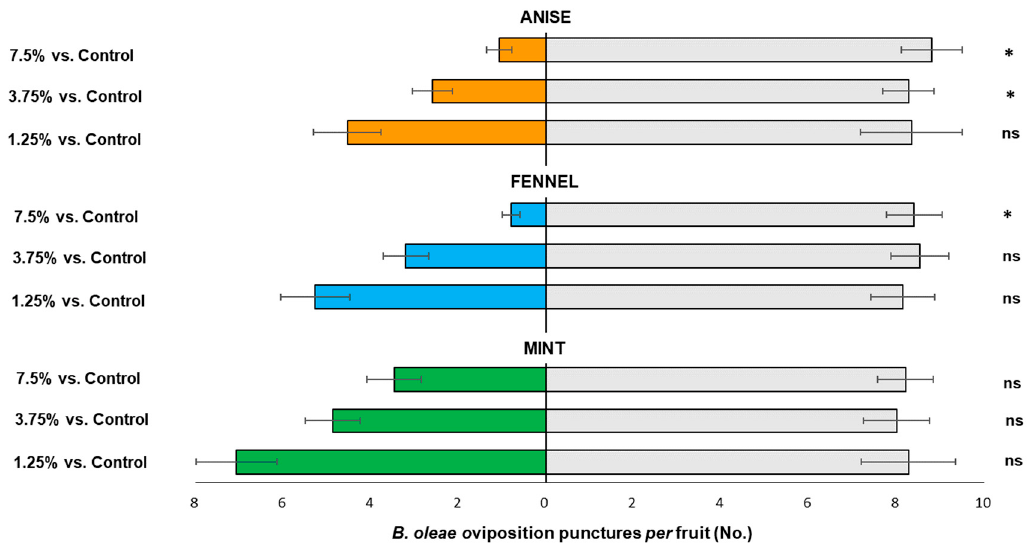
Figure 2. Oviposition behavior (mean oviposition puncture ± SE) of B. oleae females in choice trials with essential oil-treated (colored bars) versus control olives (gray bars). Three replicates (n = 10) were provided for every EO dose. Asterisks indicate significant differences between EO and control (Chi square test, p < 0.05). ns = not significant.